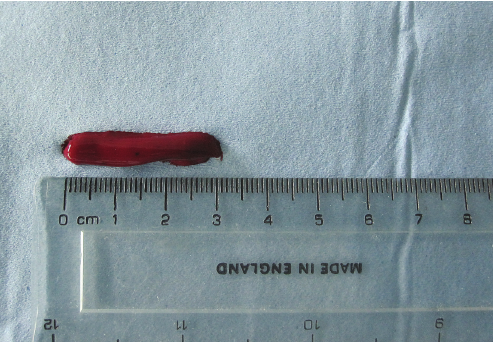
Figure 2: Prepared